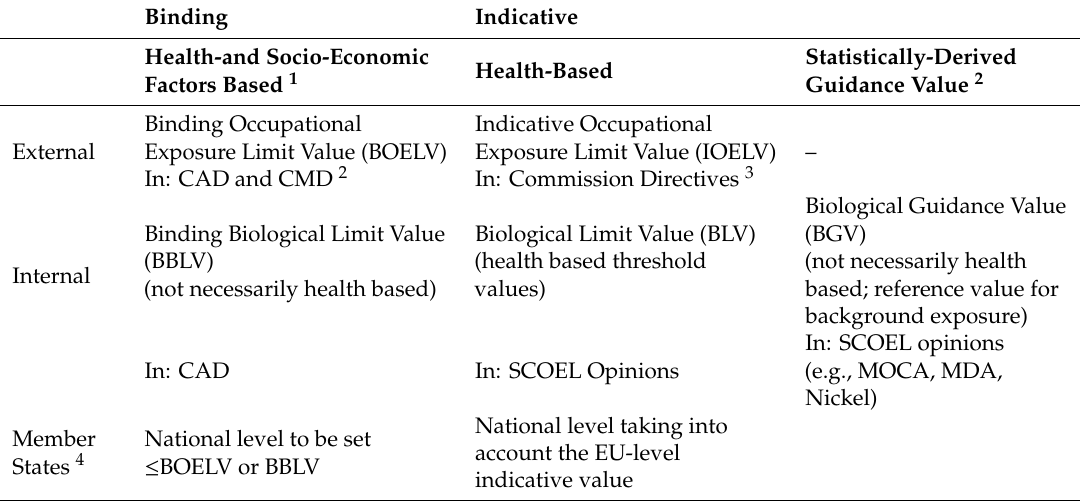
Table 1. Occupational limit and guidance values for external (airborne) and internal